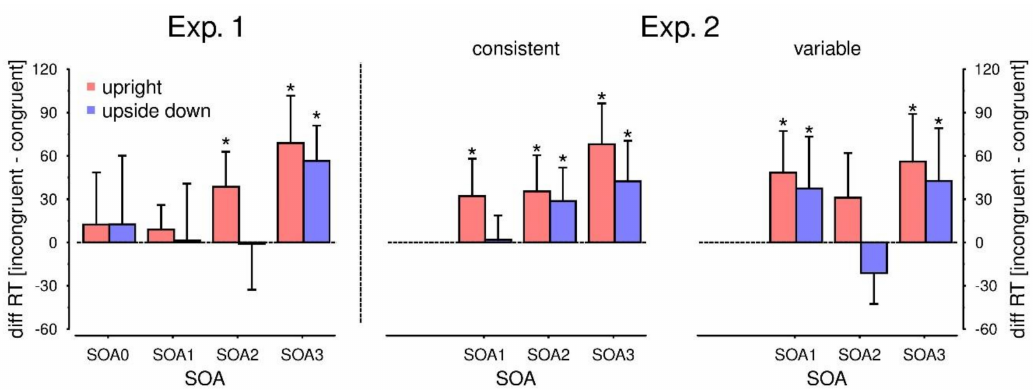
Figure 4. The aCCE per SOA as the di ff erence in verbal RT between incongruent and congruent trials. Each di ff erence was tested against a true mean of 0; significant di ff erences are indicated by an asterisk. In the left panel, data from Experiment 1 is shown. Data from Experiment 2 is shown in the central (consistent mapping) and the right panel (variable mapping), respectively. In case of the variable mapping, the aCCE disappears at SOA2 (i.e., at movement onset). Error bars indicate the 95% confidence